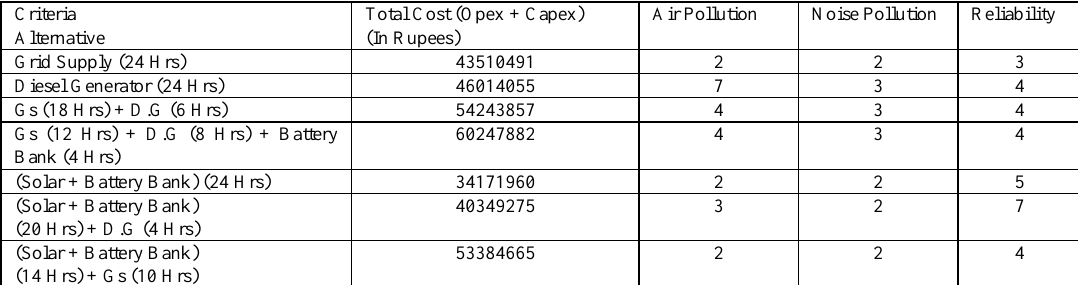
Table 5. Modified data of all the alternatives based on